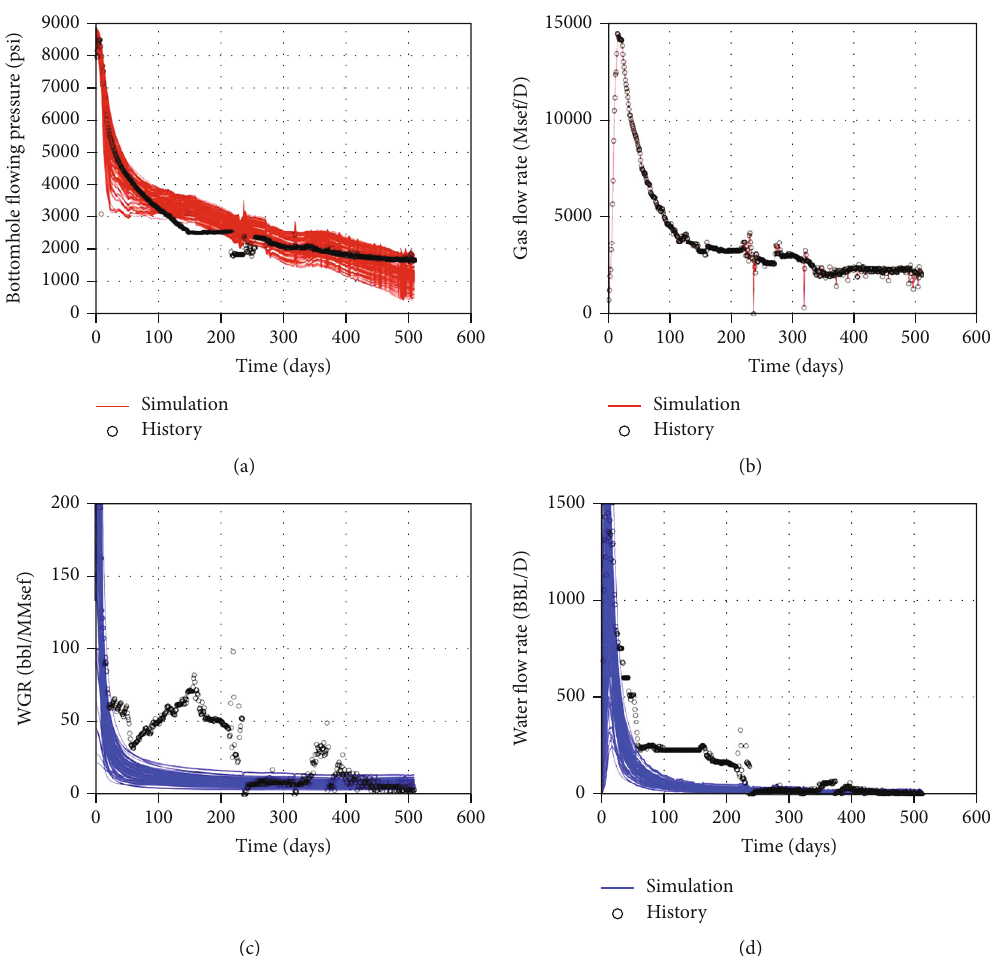
Figure 3: Comparison between 84 history matching solutions and fi eld data [26]: (a) bottomhole pressure, (b) gas fl ow rate, (c) water-gas ratio, and (d) water fl ow